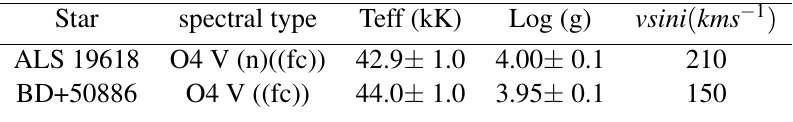
Table 2 Steller Parameters of the program